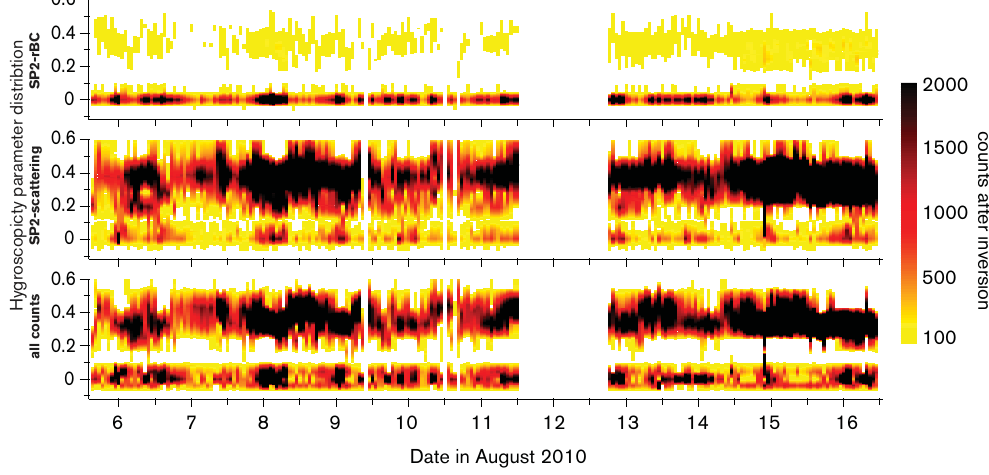
Fig. 4. Hygroscopicity parameters for mixed particle mobility dry diameter 193nm ambient aerosol measured for approximately two weeks in central Manchester by the HTDMA-SP2. The top panel shows κ for rBC-containing particles only, the middle panel shows κ values for purely scattering particles and the bottom panel shows κ of the sum of rBC and purely scattering particle.